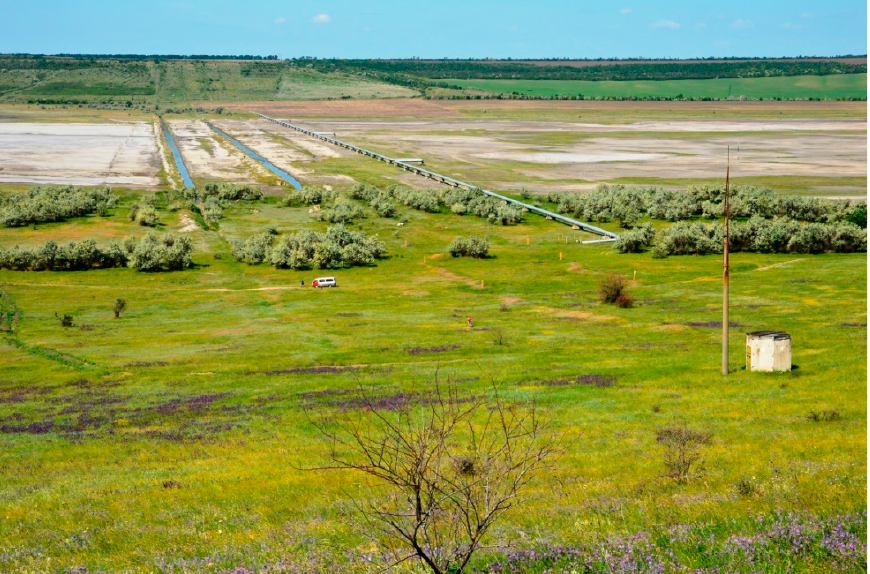
Figure 10. Product pipeline and adjacent protective hydrostructures (surroundings of Severynivka village).